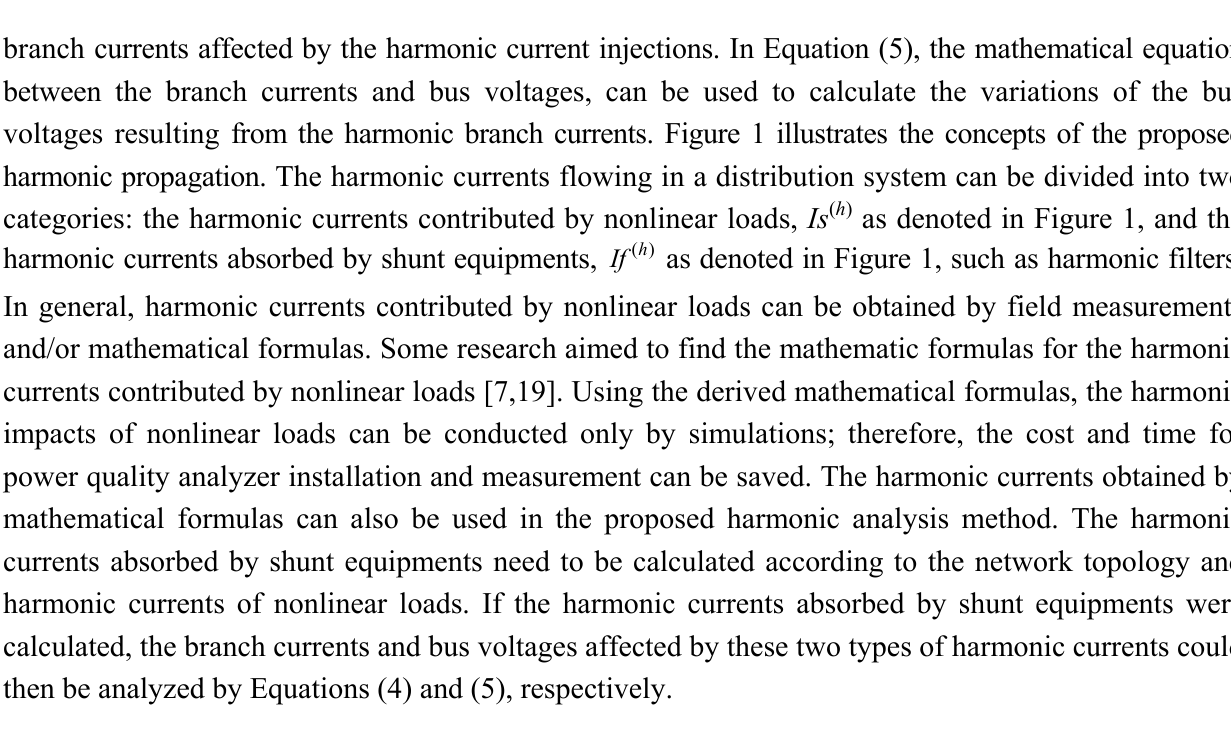
Figure 1. Concepts of the proposed harmonic